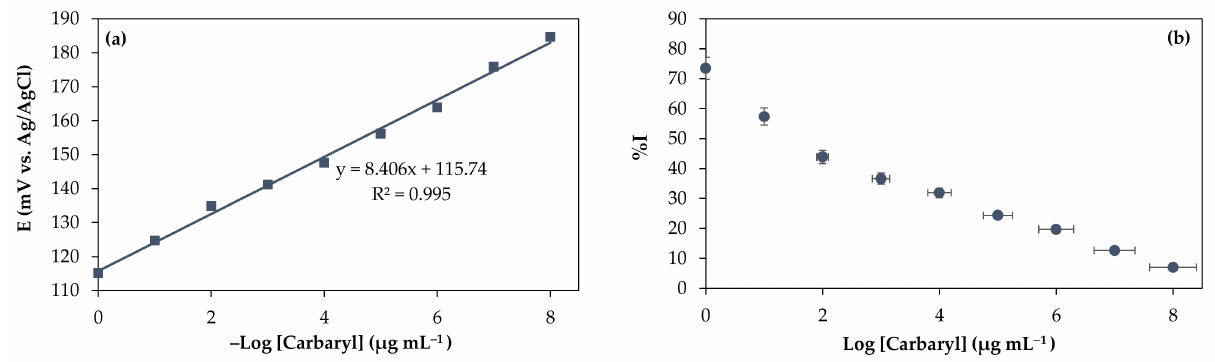
Figure 3. ( a ) Graph of the relationship of –Log [Carbaryl] with the E (mV vs. Ag/AgCl) and ( b ) the %I of carbaryl